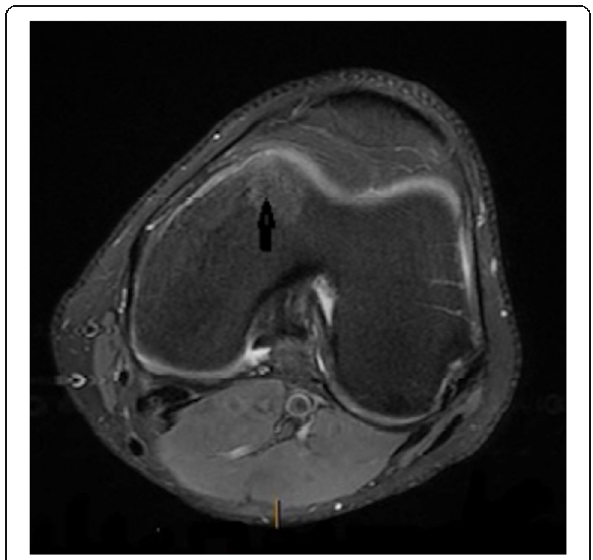
Fig. 1 Axial MRI of the left knee showing oedema in the medial